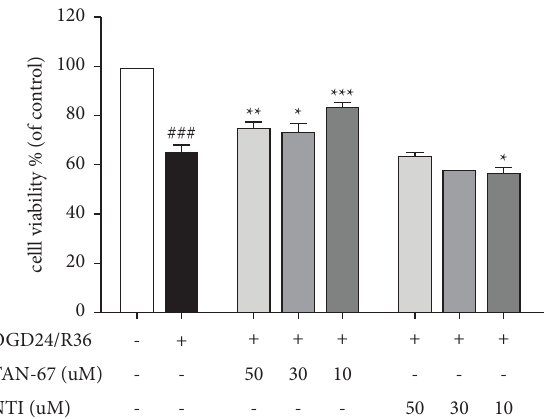
Figure 3: Te efects of the DOR agonist TAN-67 and the an- tagonist NTI on the viability of ARPE19 cells induced by OGD24/ R36. Te viability of ARPE19 cells that were pretreated with the DOR agonist TAN-67 (50, 30, 10 μ M) or the antagonist NTI (50, 30, 10 μ M) and stimulated with or without OGD24/R36 was de- termined by a cell counting kit-8 assay. (+ or − indicates with or without OGD24/R36/TAN-67/NTI) Te results are expressed as proportions of surviving cells compared with the controls ( n � 5 per group). Data are presented as means ± SEM, and group diferences were analyzed by one-way ANOVA with Dunnett’s post hoc test. ### P < 0 . 001, compared with the control group; ∗ P < 0 . 05, ∗∗ P < 0 . 01, ∗∗∗ P < 0 . 001, compared with the OGD24/R36